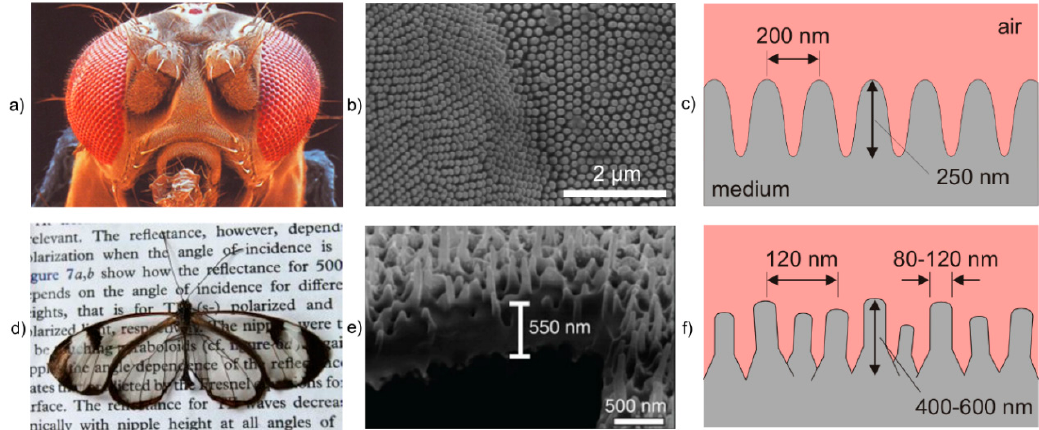
Figure 10. Examples of antireflective surfaces in nature: ( a – c ) moth eye and ( d – f ) glass wing butterfly Greta oto . ( b ) Adapted from Gonzalez and Gordon [77], Copyright 2014, with permission from OSA Publishing; ( d , e ) Adapted by permission from Macmillan Publishers Ltd.: Nature Communications, Siddique et al . [76], Copyright 2015.